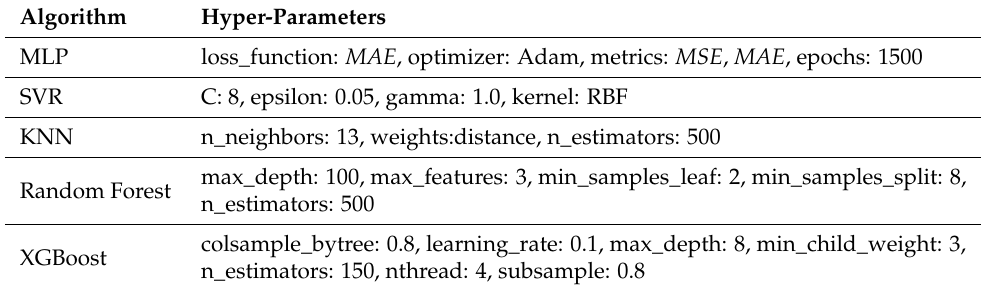
Table 3. ML Models’